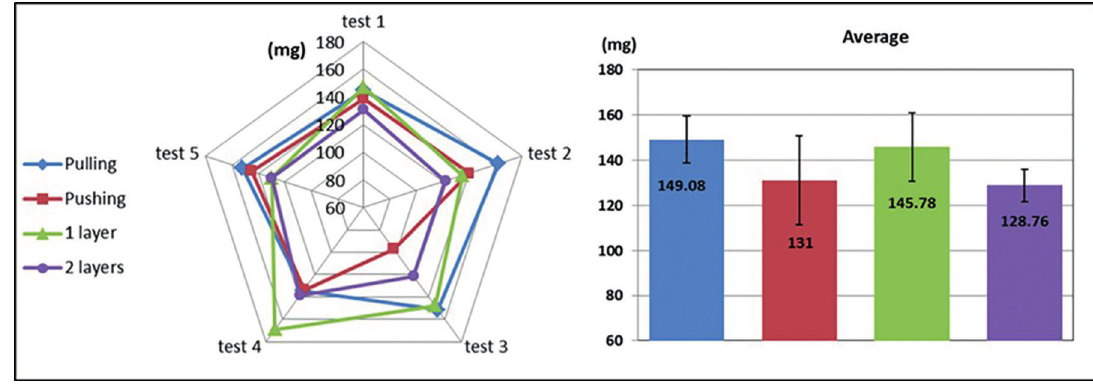
Figure 5: Weight loss of the samples subjected to abrasion tests